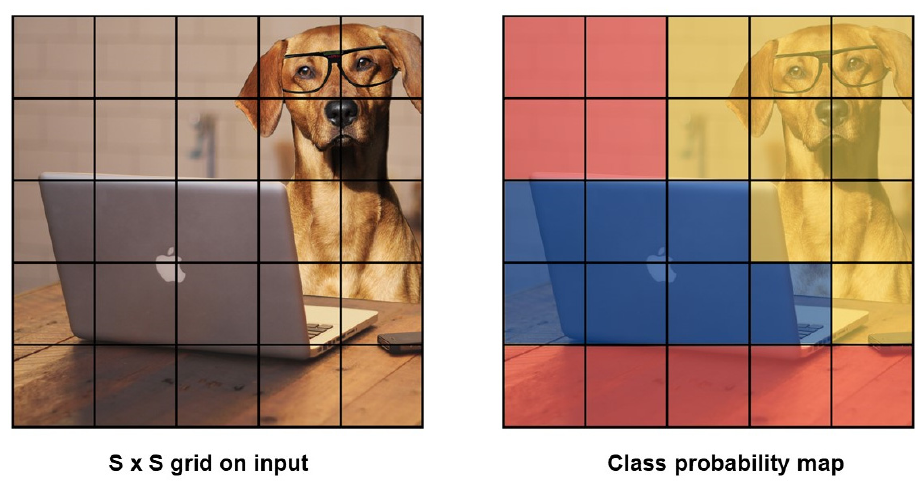
Figure 5. S × S grid distribution and class distribution map of YOLO.